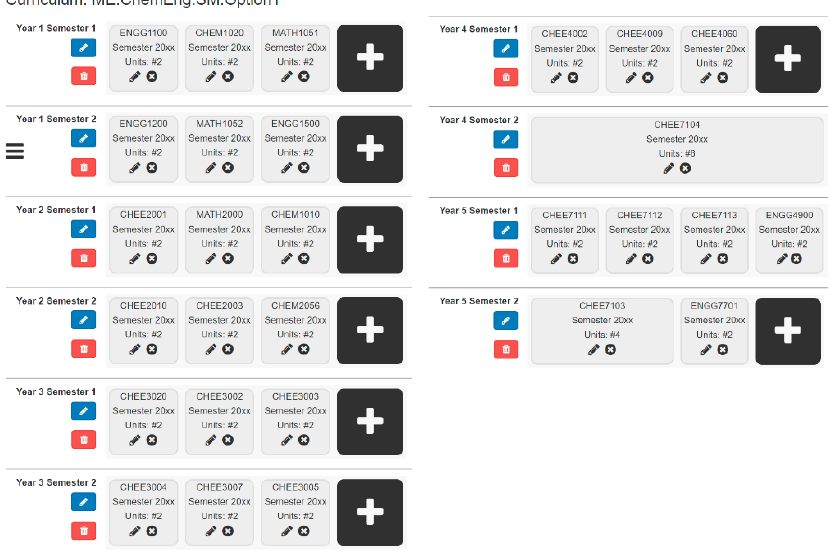
Figure 9. Compulsory course requirements for five-year BE/ME program.